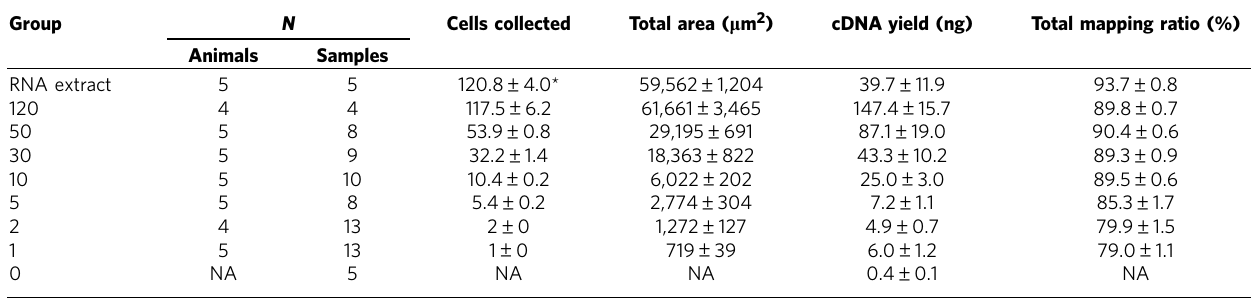
Table 1 | Specification of mouse motor neuron samples and corresponding cDNA libraries.